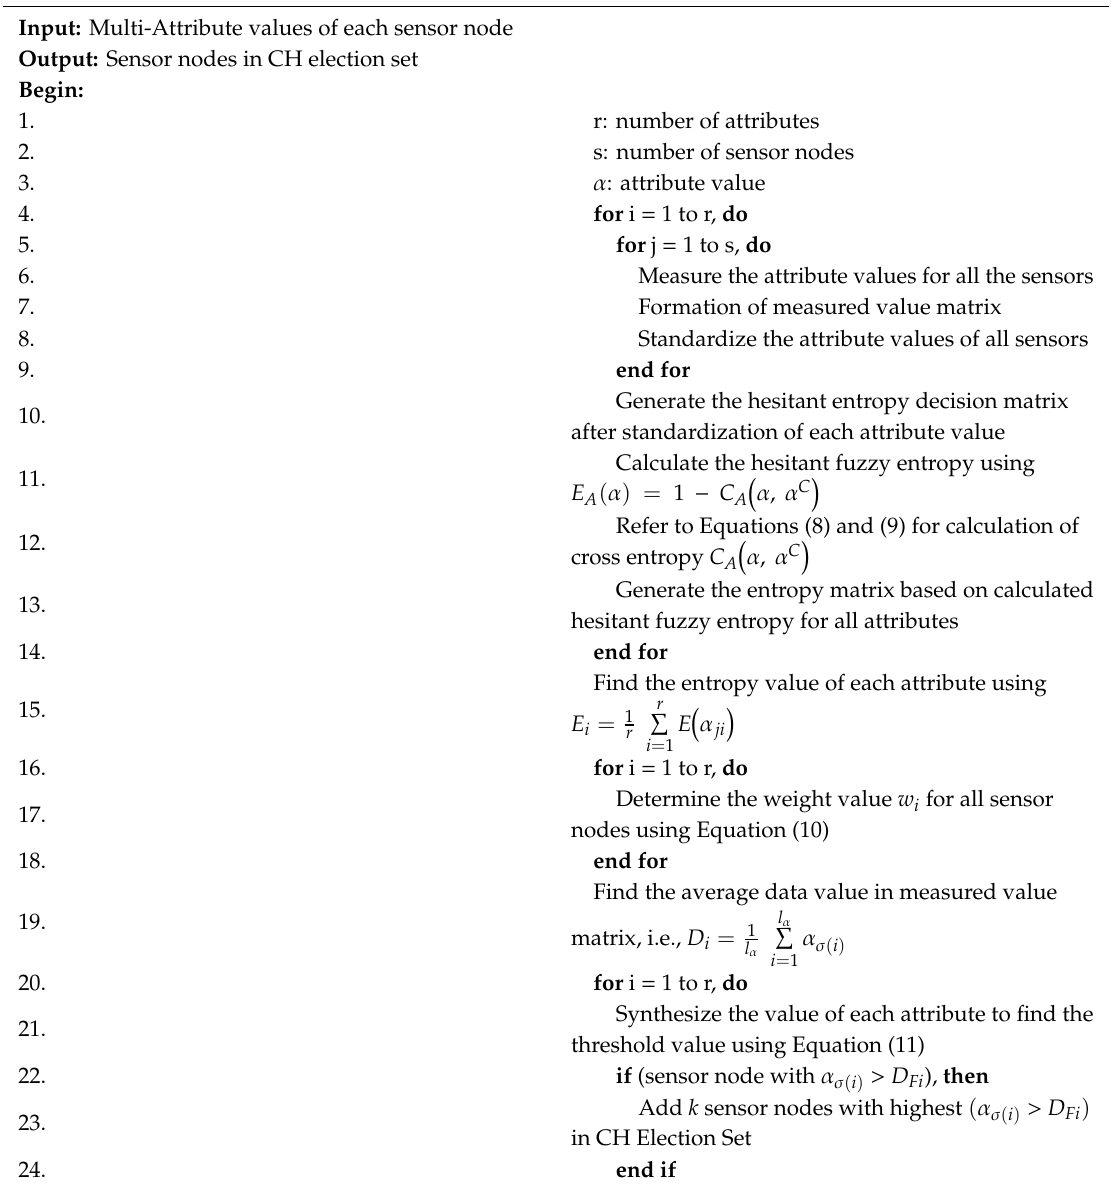
Algorithm 1. CH Election Procedure in